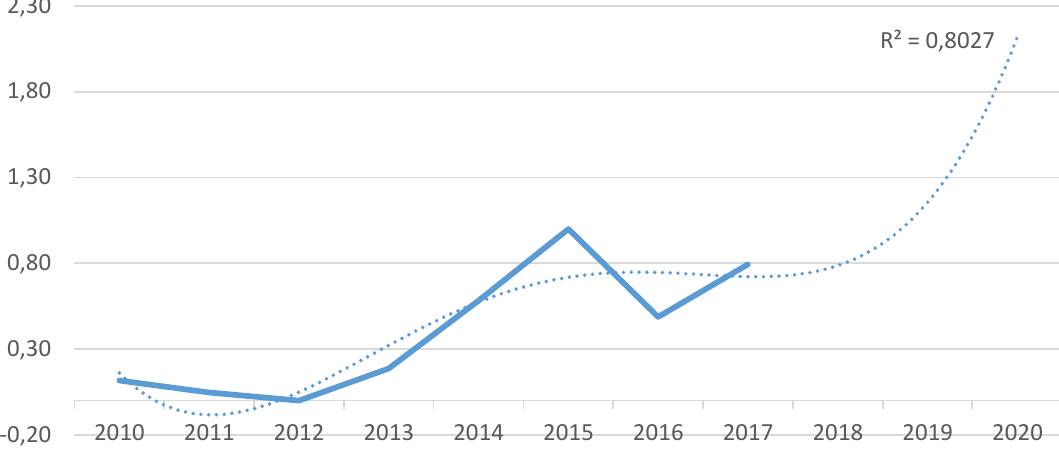
Figure 4. Forecasting the volume of investment in FinTech in Ukraine up to 2020, billion UAH